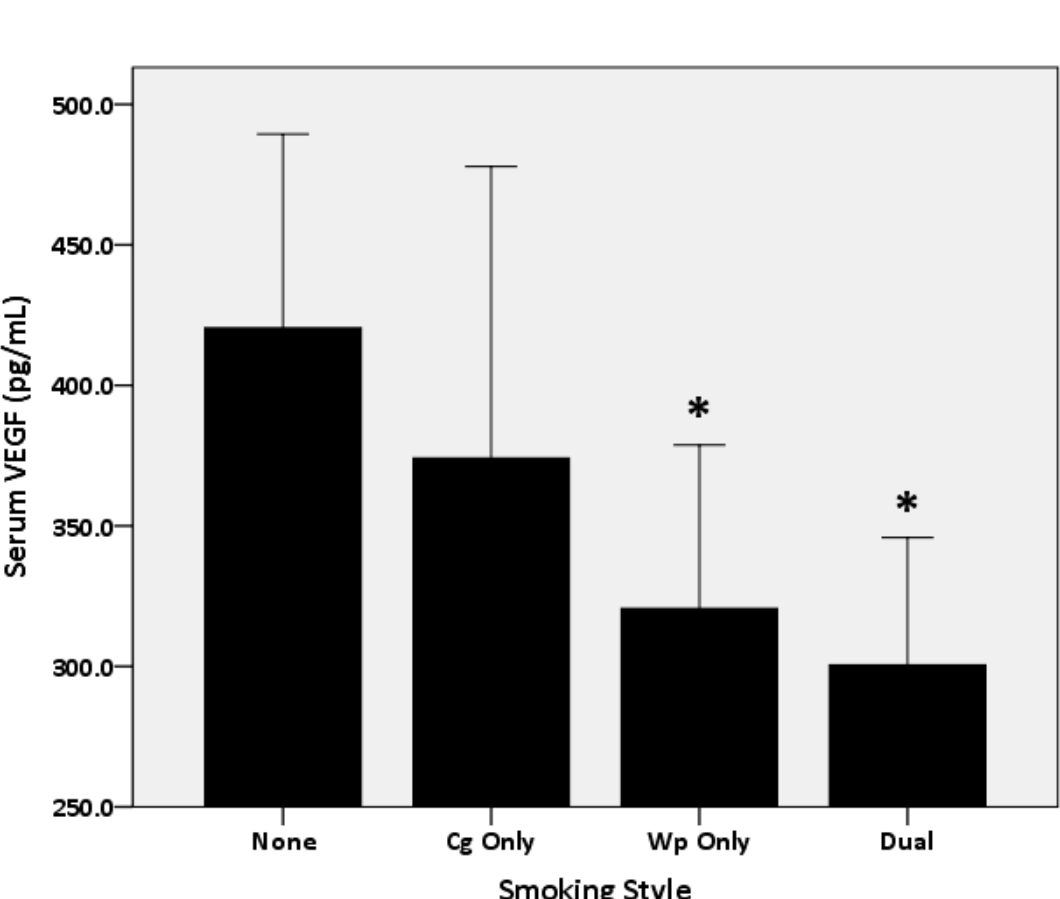
Figure 1. Comparison in serum vascular endothelium growth factor (VEGF) level among the Adolescents Smoking Cigarette Only, Waterpipe Only’ and Dual Smokers groups versus nonsmokers (None). * p > 0.05 versus nonsmokers.